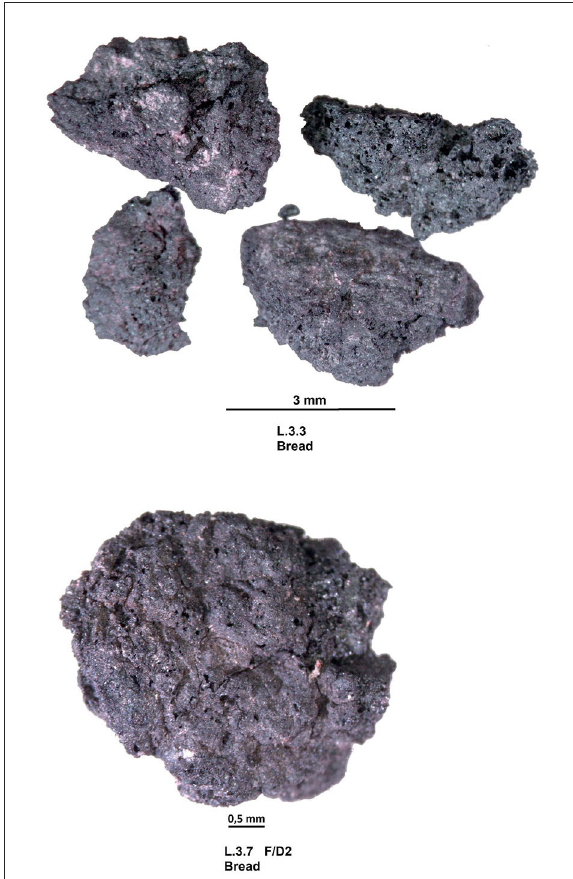
FIGURE7 Remains of charred starchy conglomerates found in the context 3.8 interpreted as a